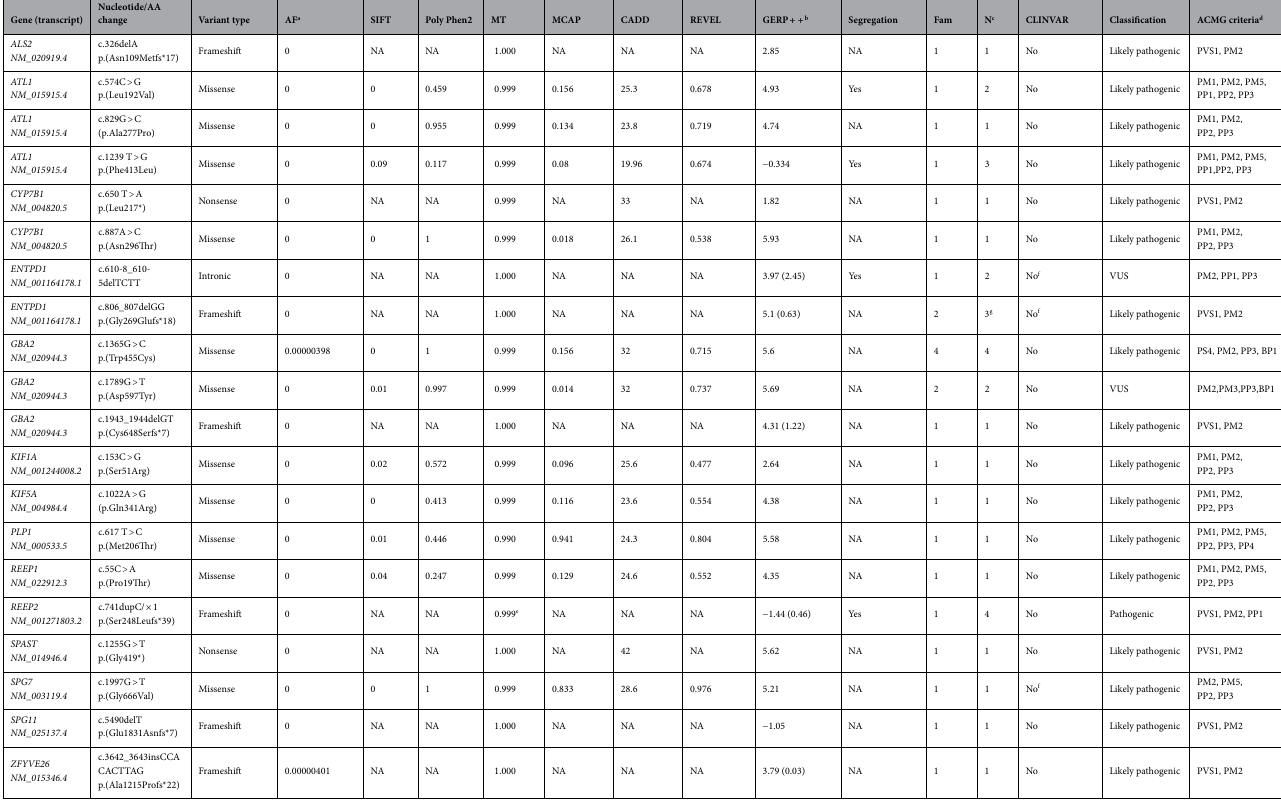
Table 2. Novel variants in muscular HSP-related genes. Allele frequencies on a gnomAD; b GERP + + data is shown as mean (standard deviation) or raw value; c total number of individuals in which the variant was detected; d American College of Medical Genetics and Genomics criteria, Richards et al., 2015; e polymorphism prediction; f ClinVar descriptions are related to the reported cases; g Two patients with genetic diagnosis and one deceased sibling with clinical diagnosis. AA amino acid, AF allele frequency, Fam families, MT mutation taster, NA not available, VUS variant of unknown